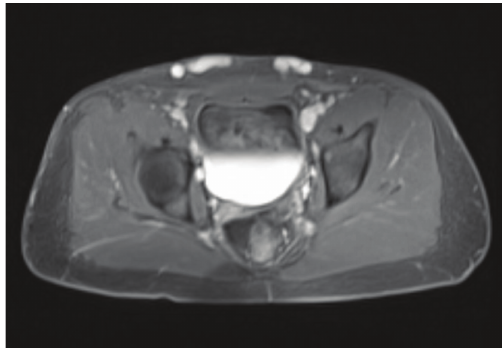
Figure 2: Axial MRI of pelvis with contrast showing large suprapubic varicosities (white arrows) and a small right external iliac (short arrows). The left external iliac vein is larger (long arrows).